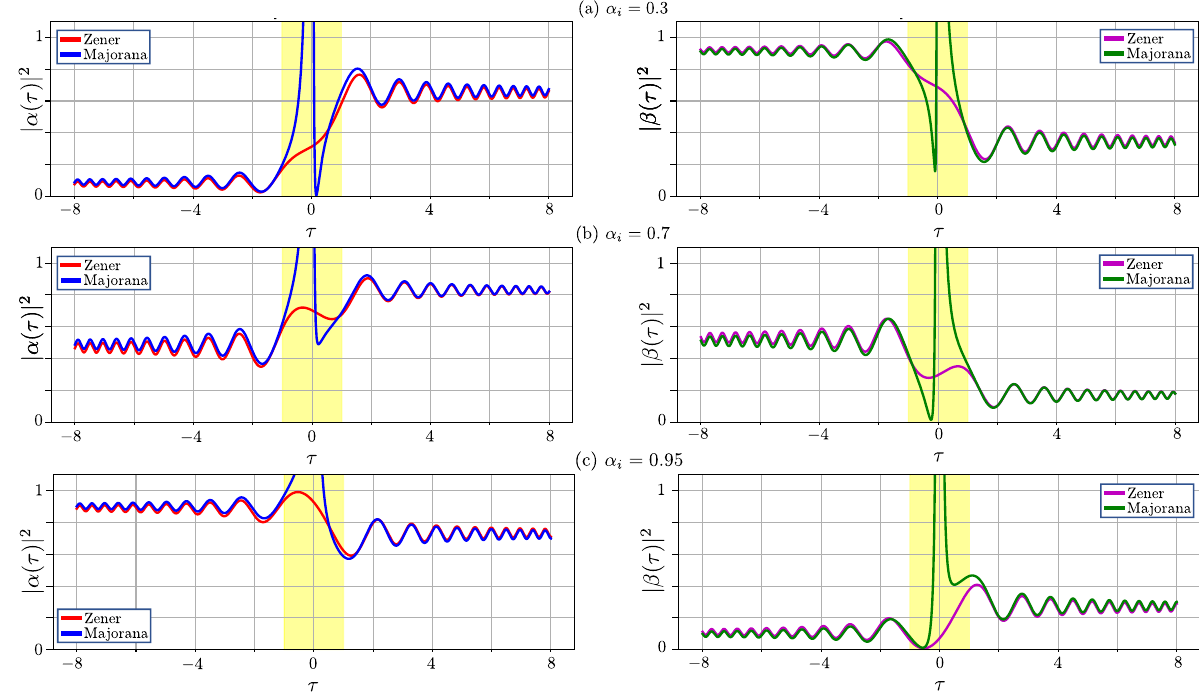
Figure 4. Time-evolution of the occupation probability when starting from different initial superposition states. Similarly to Fig. 3, we present the comparison of the dynamics obtained by following Majorana’s method and Zener’s method, now for three different initial states, with α i adiabaticity parameter here is δ